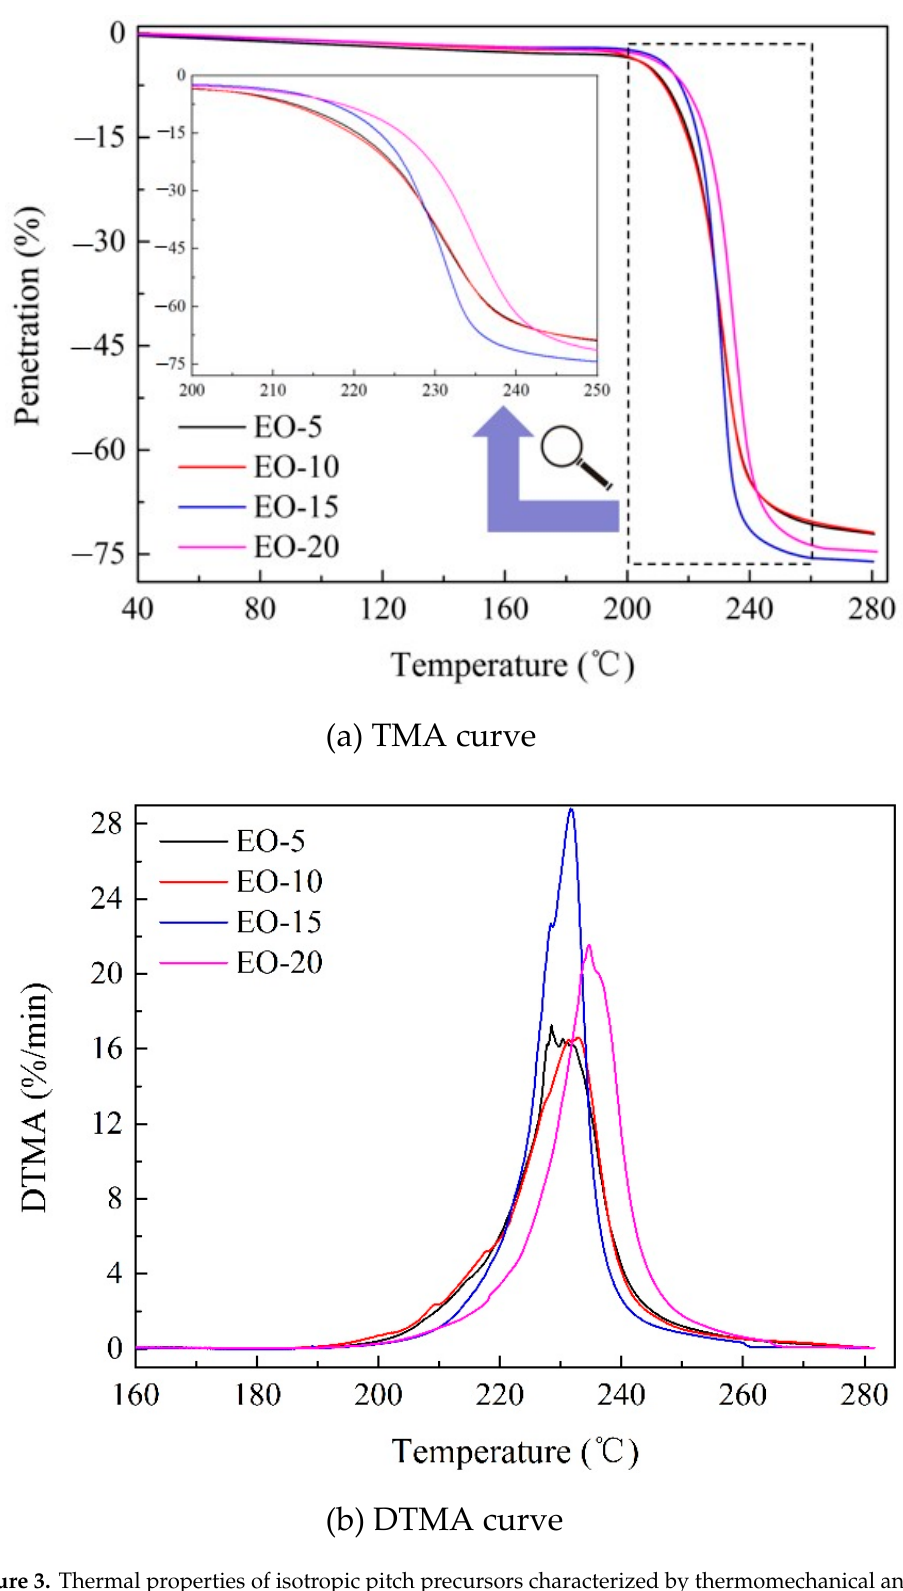
Figure 3. Thermal properties of isotropic pitch precursors characterized by thermomechanical analysis, ( a ) TMA curve and ( b ) DTMA curve.